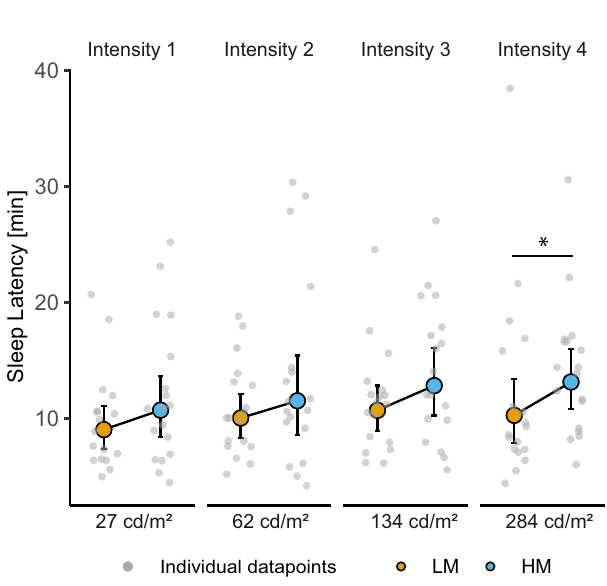
Fig. 2 Sleep latencies to stage N2 in minutes after lights off. Depicted are back-transformed means for the low melanopic condition (LM: orange points) and the high melanopic condition (blue points) and 95% CIs (black lines) in the four light intensity groups ( n = 18 per group, except LM intensity 1 n = 17). Grey points represent the individual values of participants. Black asterisks indicate the statistically signi fi cant main effect ( p < 0.05) of the fi xed factor light condition, computed in a linear mixed